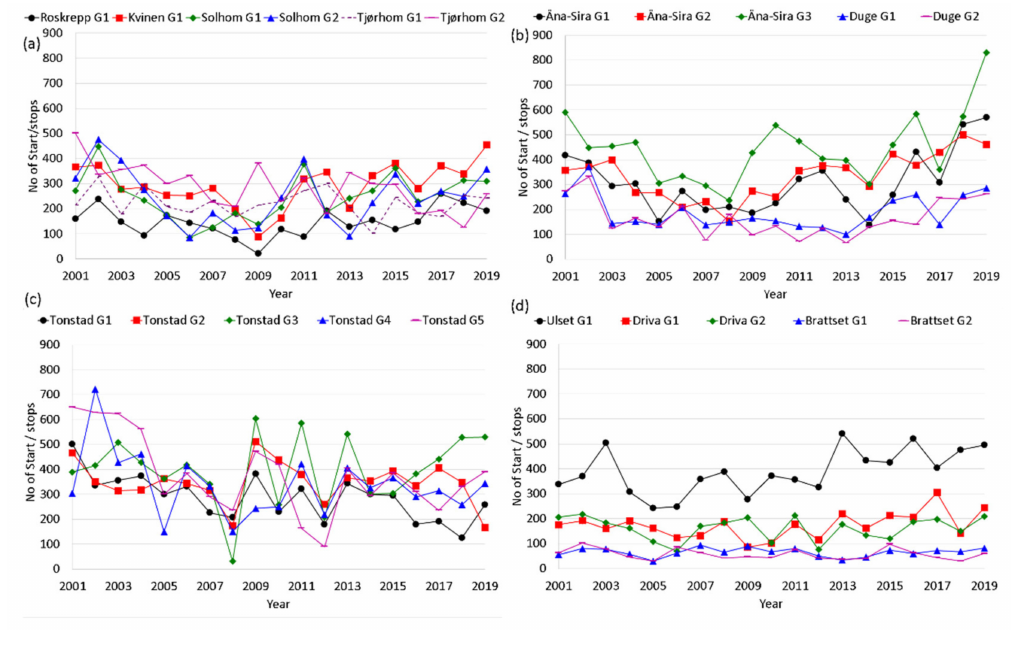
Figure 3. Number of start/stops of various powerplants between 2001 and 2019.